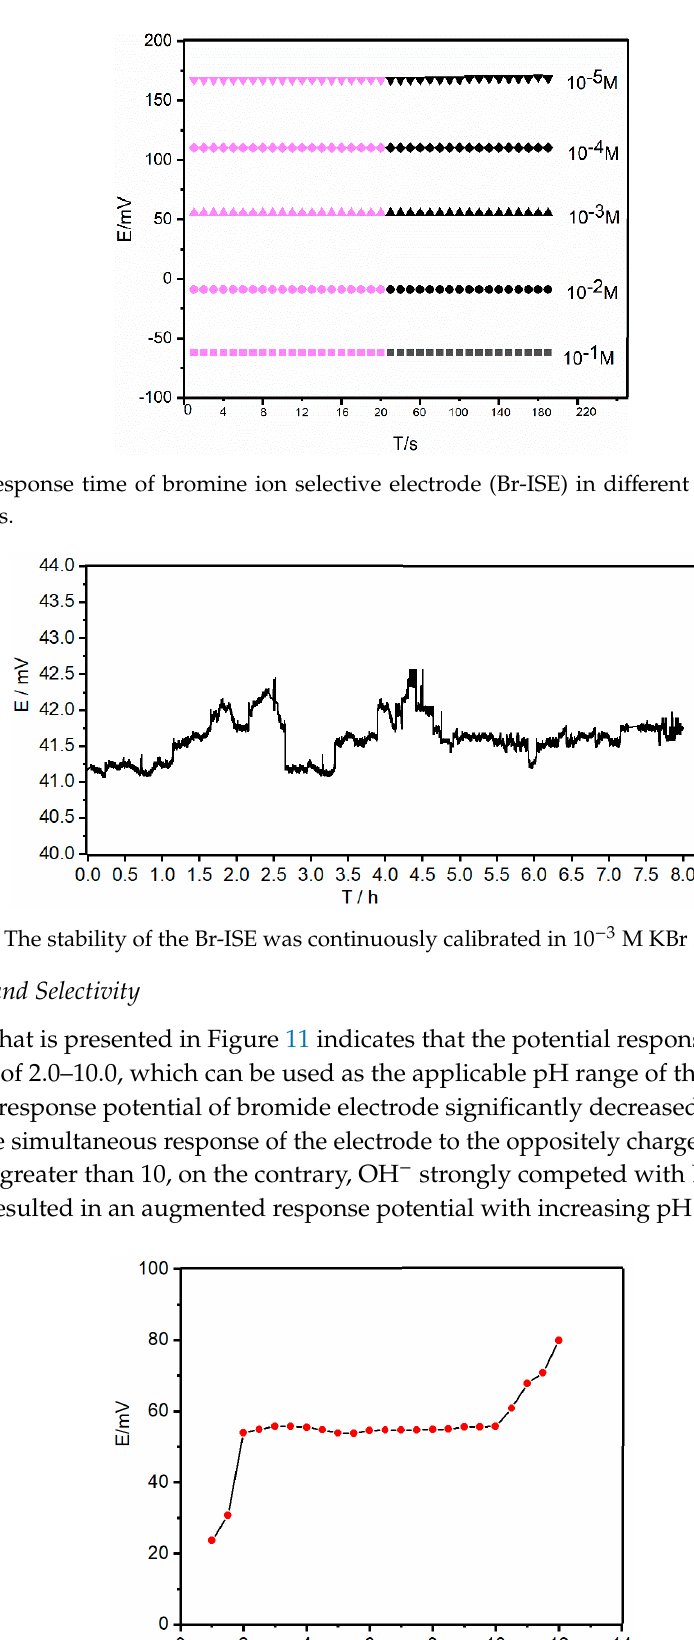
Figure 11. Effect of pH on potential response of the Br-ISE using 1 × 10 − 3 M KBr solution. Figure 11. E ff ect of pH on potential response of the Br-ISE using 1 × 10 − 3 M KBr The main interfering ions that are selected (including Cl − , I − , F − , NO 3 − , NO 2 − , SO 42 − , SO 32 − ,